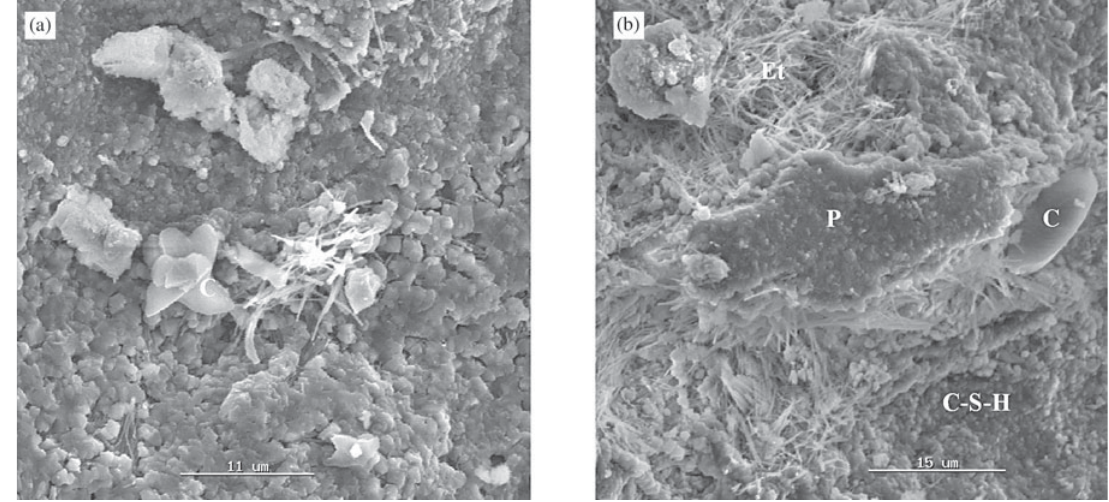
Figure 4. Photomicrographs of Concrete: a) presence of carbonates (C); b) several elements of the microstructure: carbonates (C), portlandite (P), calcium silicates (C-S-H) and ettringite